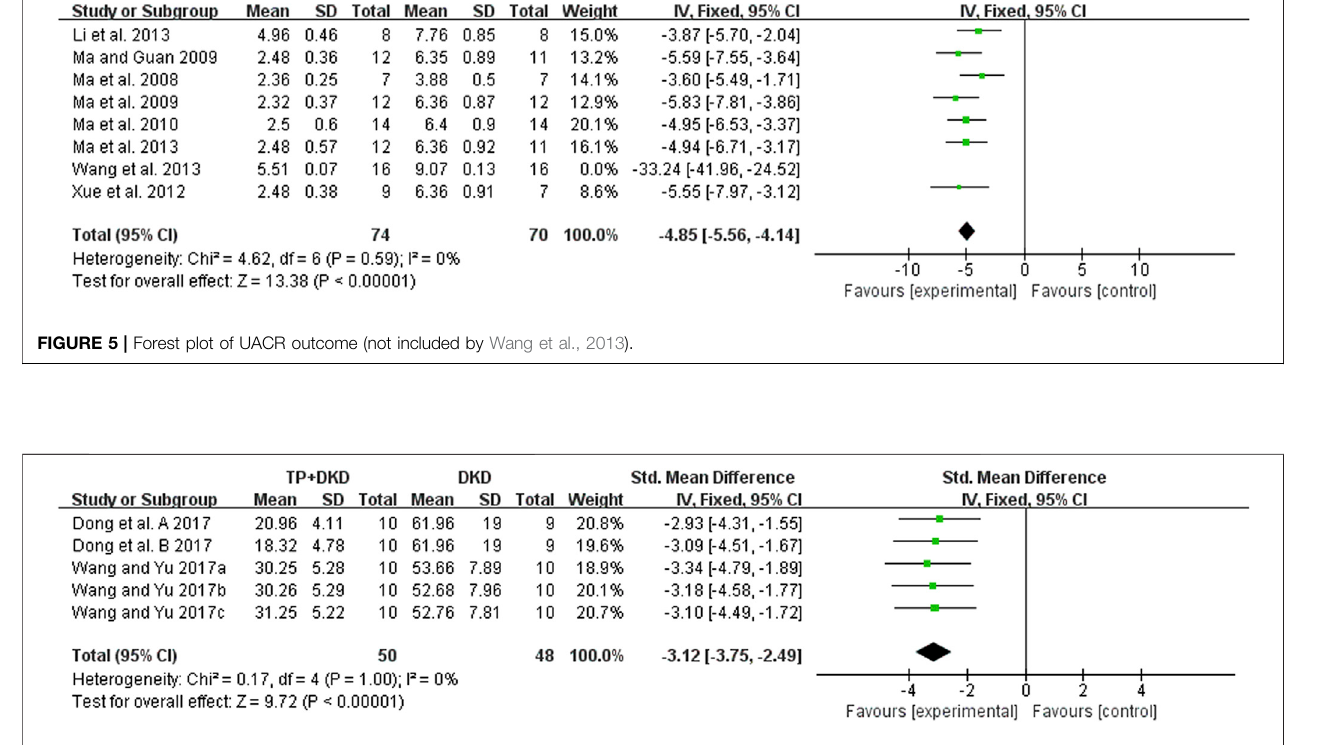
FIGURE 6 | Forest plot of UP